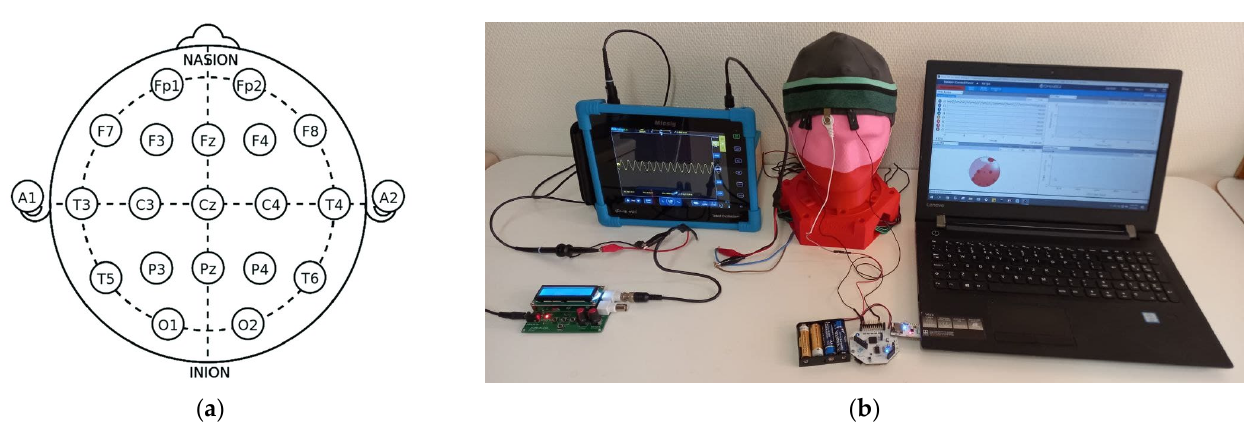
Figure 11. ( a ) The 10–20 international system of EEG electrode placement [42], under CC by 4.0; ( b ) synthetic scheme 2. The initial peak-to-peak voltage signal is the synthetic peak-to-peak voltage injected from the digital oscilloscope to the head phantom. Thus, the actual peak-to-peak voltage signals are the peak-to-peak voltage collected from the head phantom and the peak-to-peak voltage noise is the difference between the injected and collected back peak-to-peak voltage signal.